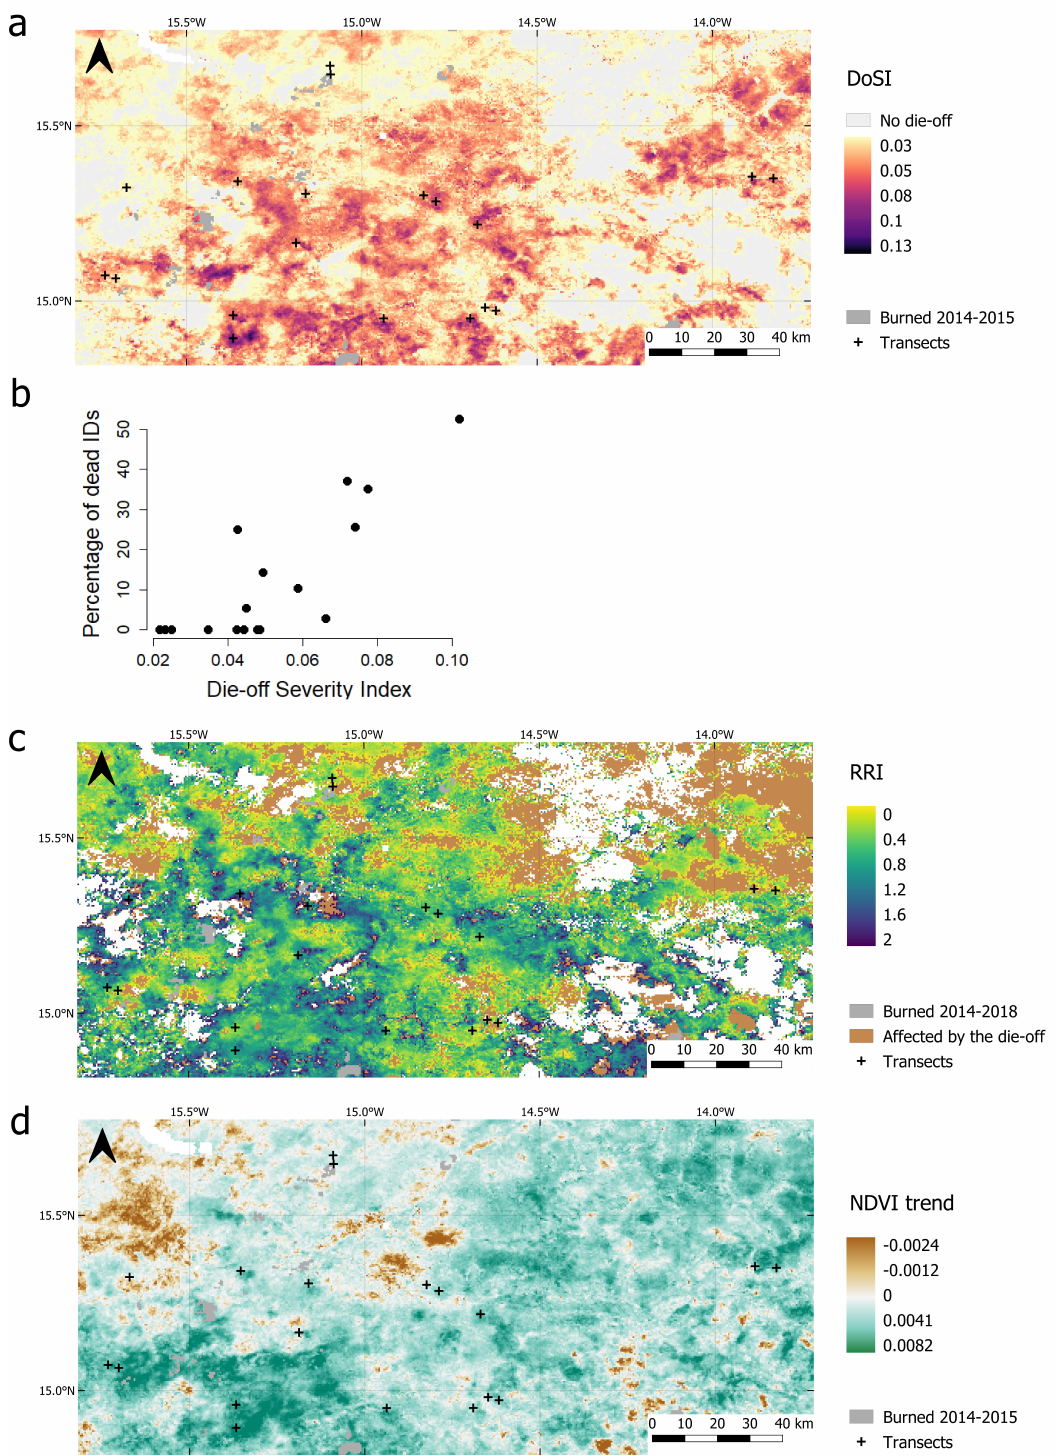
Figure 6. ( a ) The Die-off Severity Index (DoSI). Darker colours represent a higher die-off severity. Negative DoSI values were grouped as “No die-off”. ( b ) Relationship between the percentage of dead woody individuals (IDs) measured in the field and the DoSI. ( c ) The Relative Recovery Indicator (RRI). Pixels within the yellow-blue colour ramp were affected by the die-off event but presented signs of recovery. Darker colours represent areas where woody vegetation recovery, relative to the level of mortality, was higher. Brown pixels were affected by the drought but did not show signs of recovery. ( d ) NDVI dec trend between 2010 and 2013, representing areas with high/low woody vegetation accumulation before the